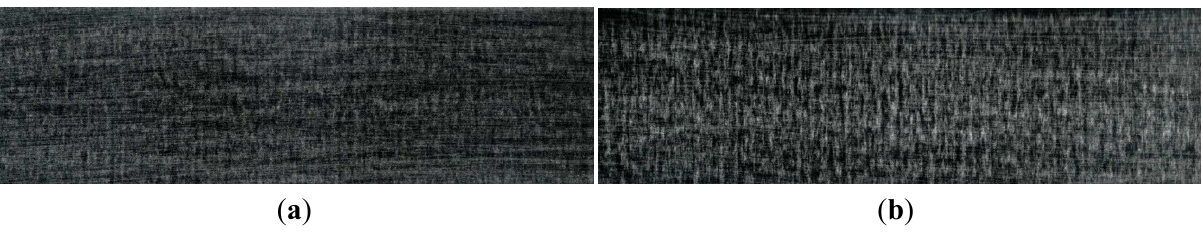
Figure 13. Roping behavior: ( a ) no/little roping; ( b ) clearly visible roping.